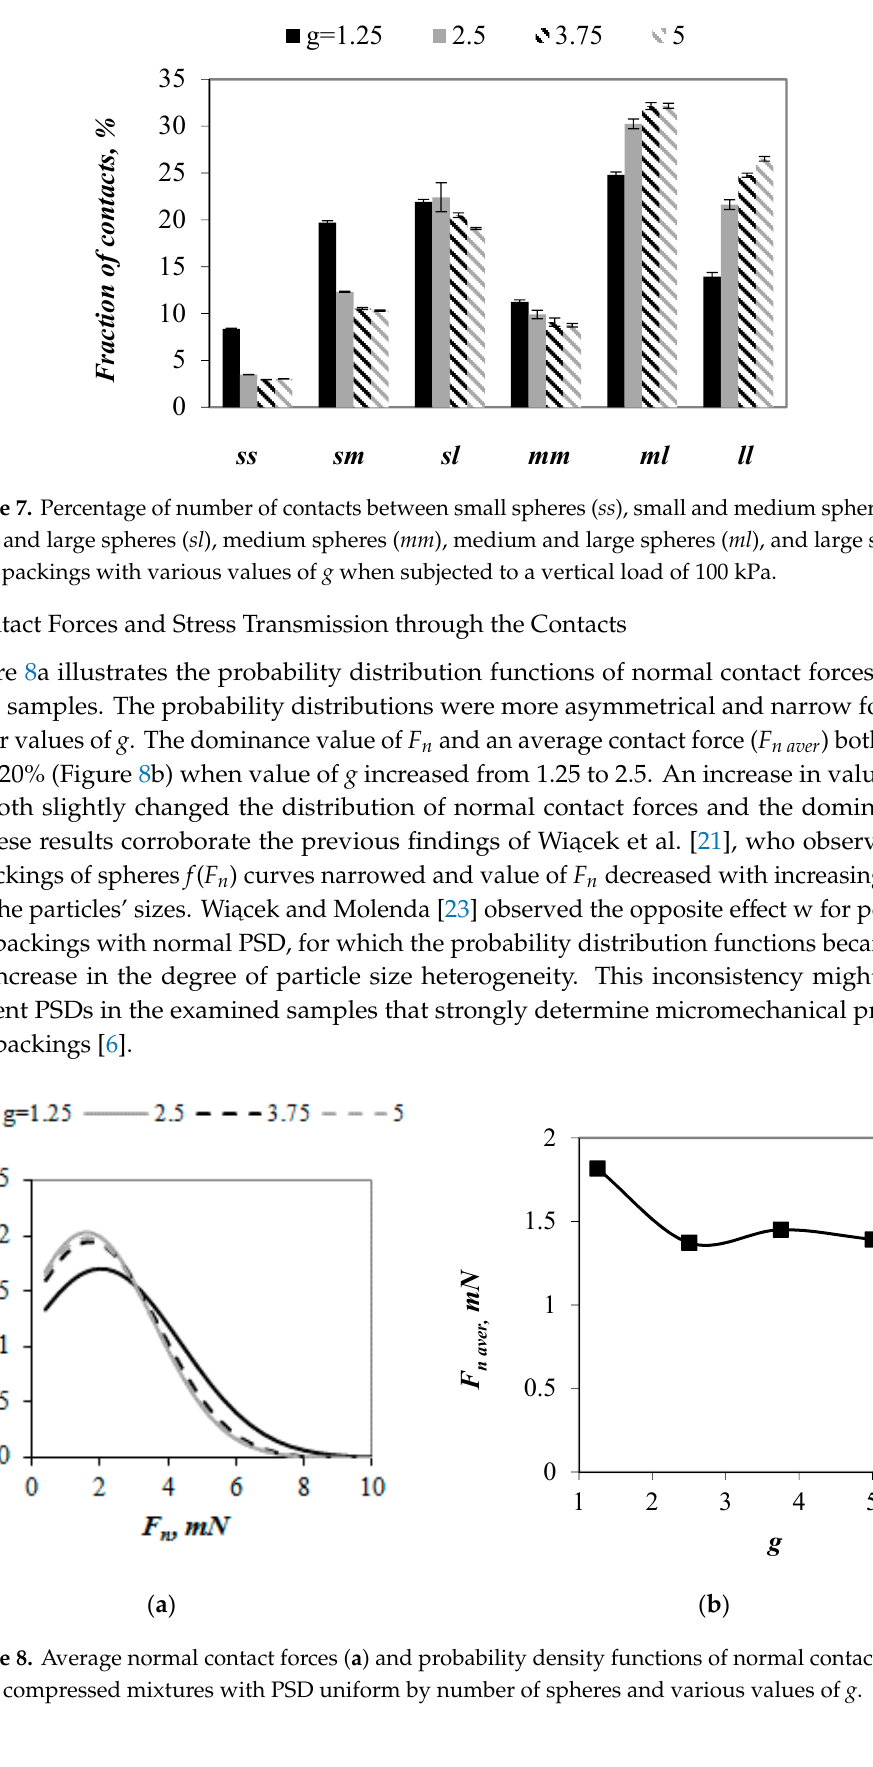
Figure 9. Percentage of contacts with Fn > 0.75 Fn aver in mixtures with various values of g. The effect of the particle size ratio on the global and partial stresses in ternary granular packings was studied. The mean particle stress is defined as [38]: )( 31 pp trp σ=